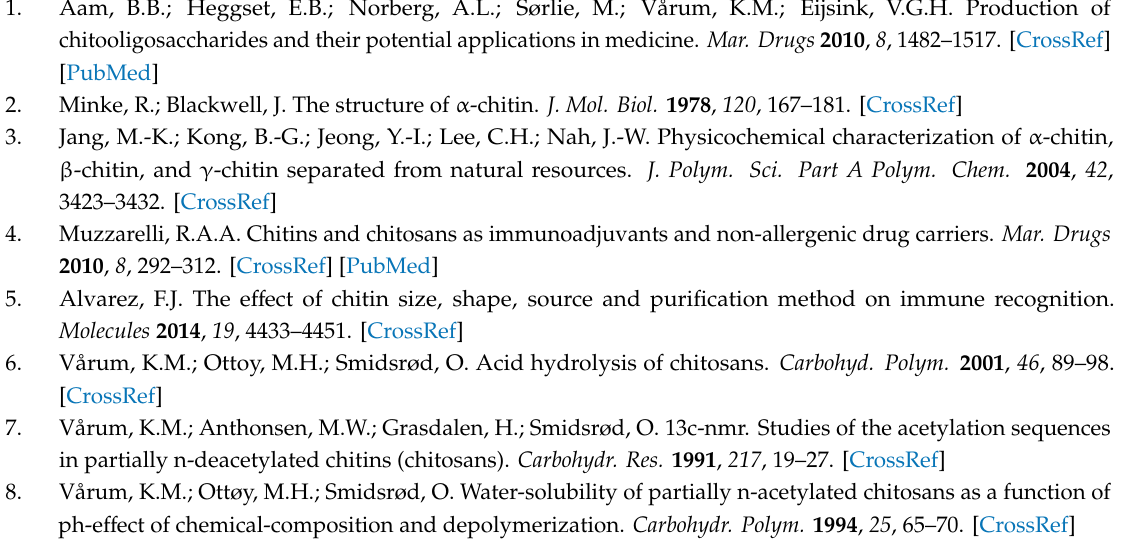
chitobiose after incubation with Vc CDA for 24 h. Figure S2: Table S1: SDS PAGE GEL analysis of Vc CDA, Sp PgdA, and An